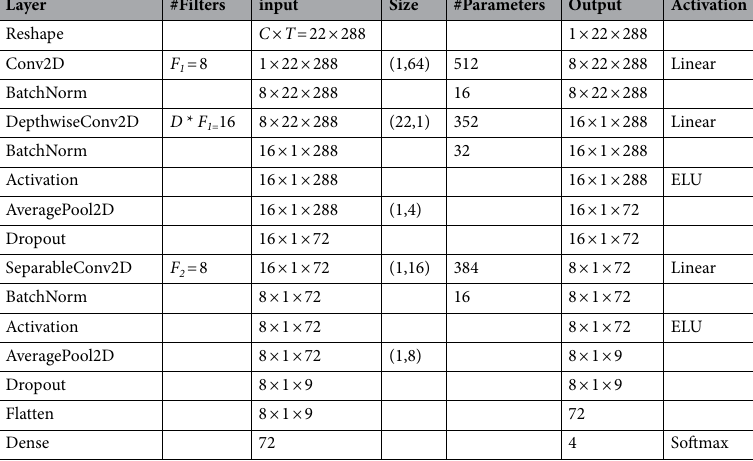
Table 1. The example architecture of Compact-CNN as a classifier on BCI competition IV-2a data